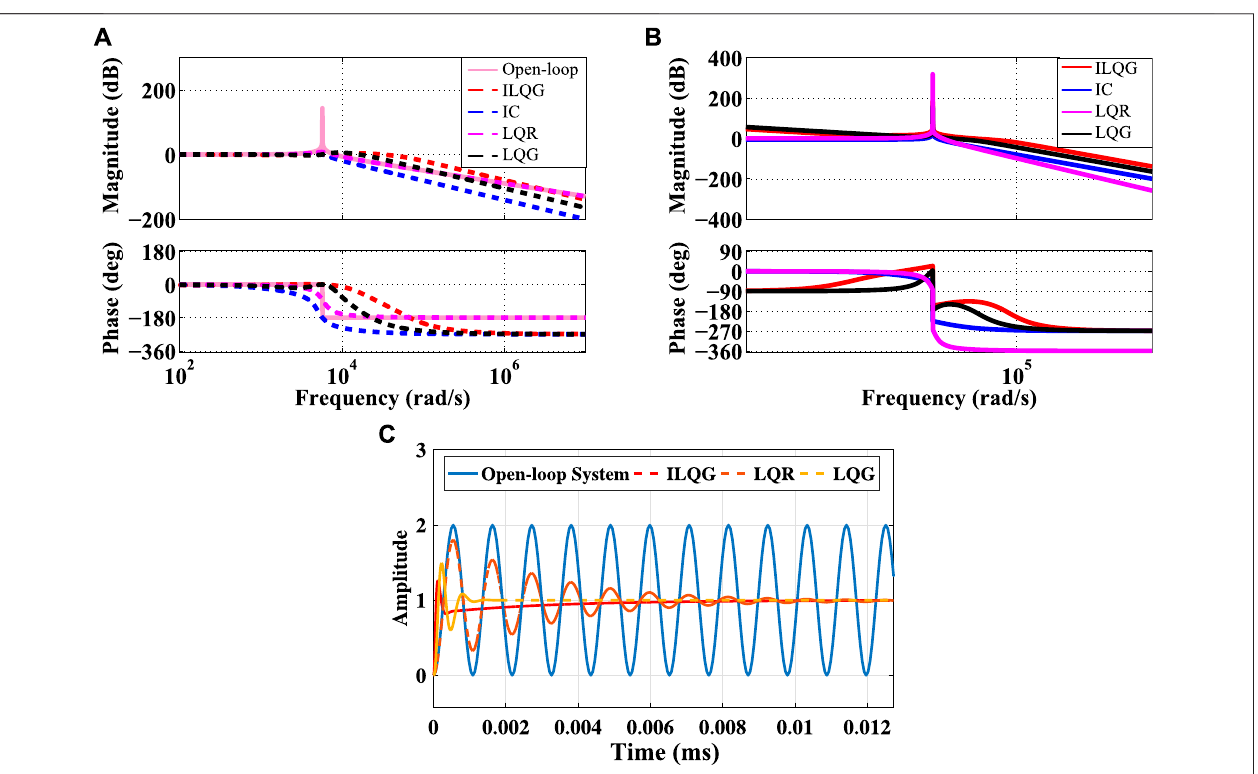
FIGURE 10 | Comparative performance between (A) proposed controller, linear-quadratic Gaussian (LQG), LQR and Integral controller (IC) for Closed-loop Bode diagram, (B) proposedcontroller,LQG, LQR, andICforBodediagram oftheloop-gain G p C , (C) ILQG, LQG,LQR controllerusing time-domain response.WhereGand C represents the SN plant and controller.